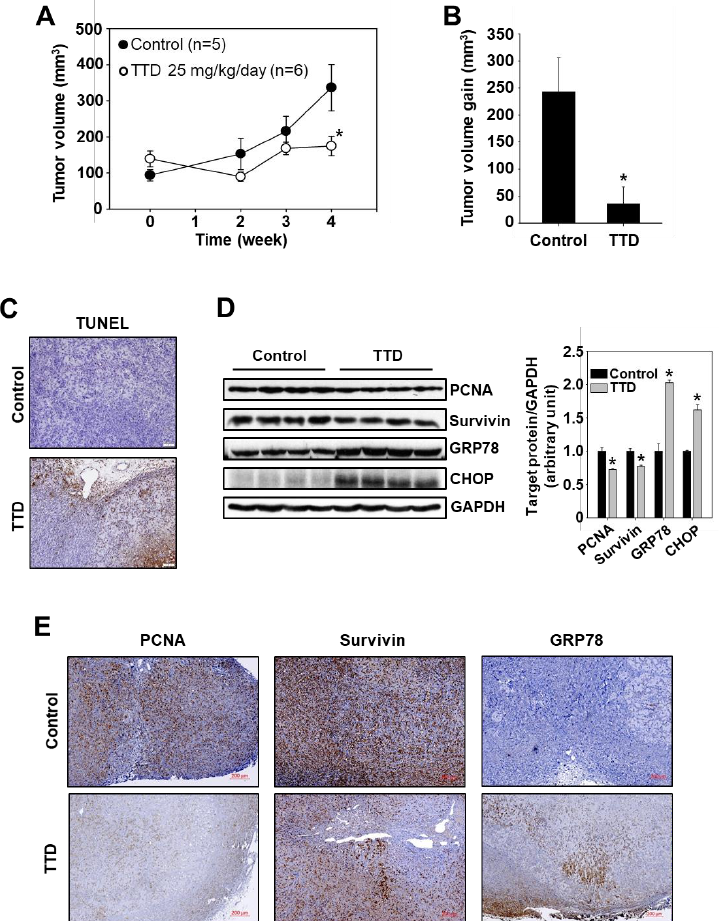
Figure 6. Effects of TTD on growth and apoptosis in a mouse xenograft model of human pancreatic cancer. Panc-1 cells were implanted into athymic nude mice as described in the Materials and Methods section. Each mouse was dosed by oral gavage with either corn oil (control) or TTD (25 mg/kg/day) for four weeks. ( A , B ) Median tumor volumes were calculated as described in the Materials and Methods section. The results are presented as means ± SD. * p < 0.05 vs. the control group. ( C ) Tumor sections were stained using the DeadEnd colorimetric kit as described in the Materials and Methods section. Images of the apoptotic tumor cells were collected at high ( × 100) magnification. ( D ) Tumor lysates were analyzed by western blot analysis, and GAPDH was used as a loading control. The results are presented as means ± SEM ( n = 4 replicates). * p < 0.05 vs. the control group. ( E ) Immunohistochemistry shows the expression of PCNA, survivin, and GRP78 in tumor